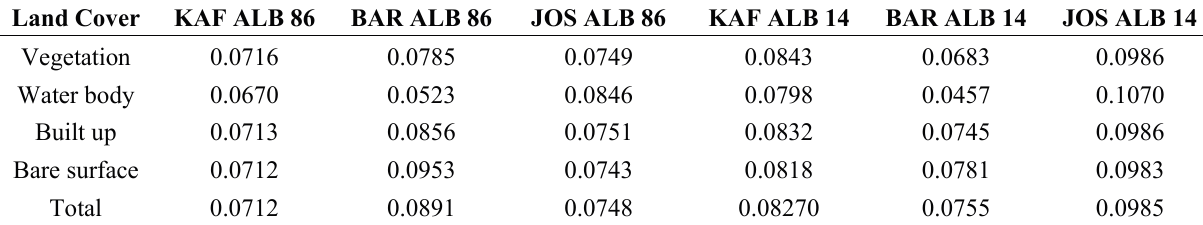
Table 12. Mean albedo across landcover and